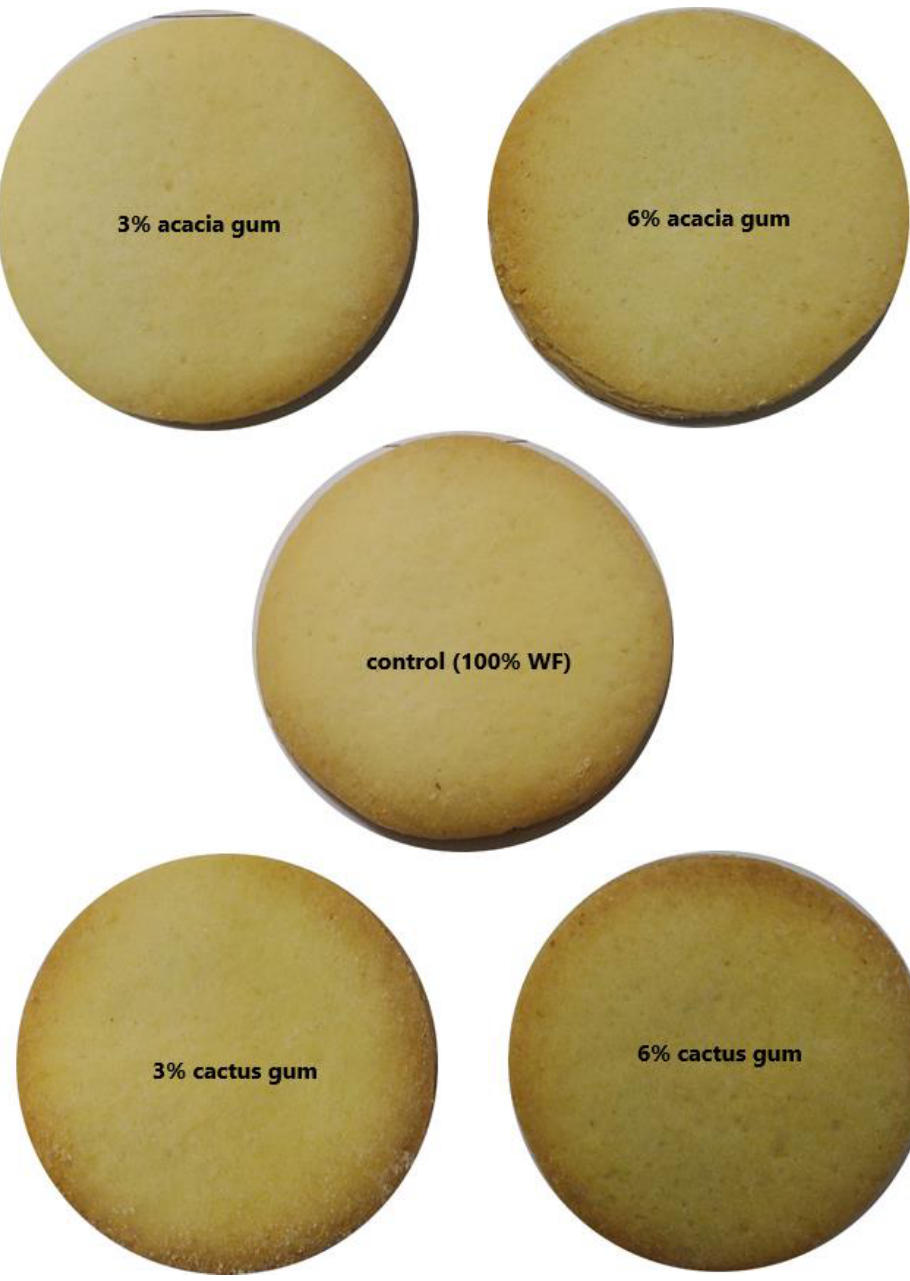
Figure 3. Pictures of cookies prepared from flour